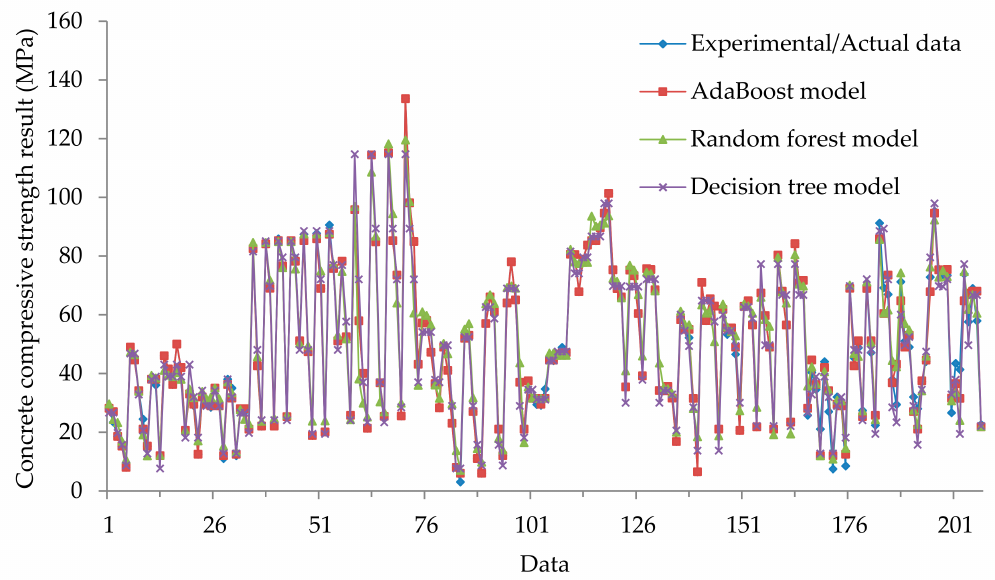
Figure 5. Compressive strength results of AdaBoost, RF, and DT models in training and testing phases.